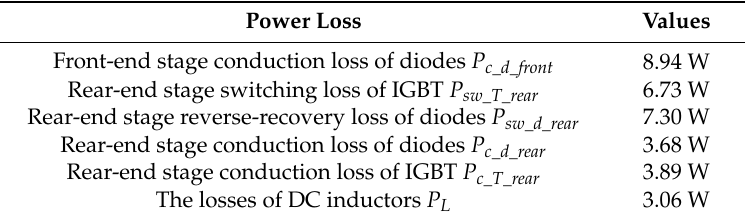
Figure 6. Efficiency variation with the input current rms. Table 2. The power loss of each component when the rms of input current is 3 A.